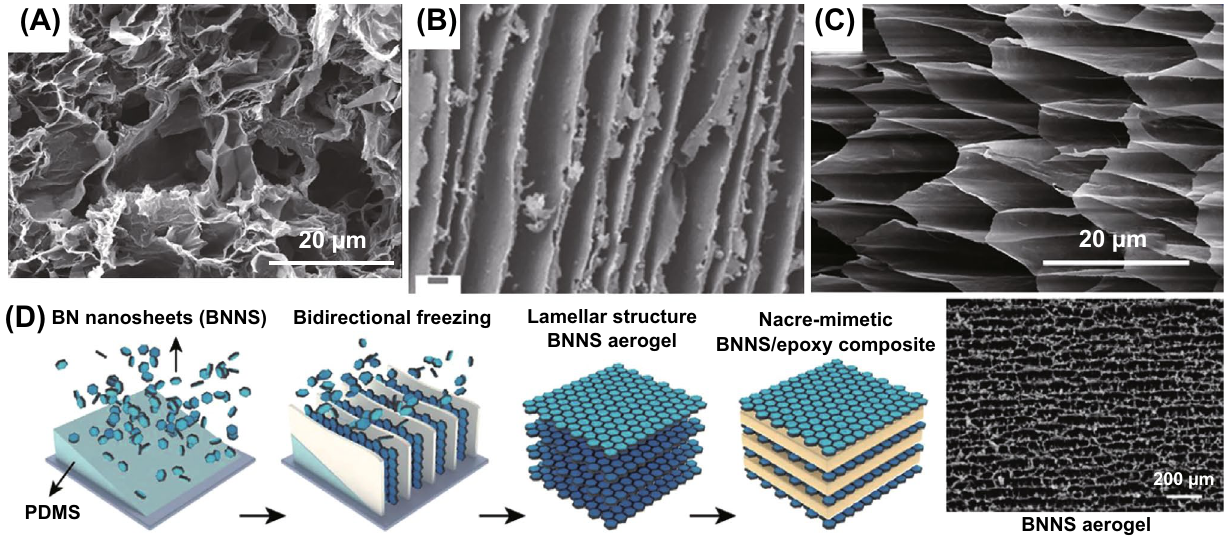
Fig. 7 A SEM of disordered freeze-dried of cellulose/graphene nanoplatelets. Reprinted with permission from Ref. [115]. B SEM of freeze- dried anisotropic porous MWCNT/WPU composites. Reprinted with permission from Ref. [116]. C SEM of unidirectional freeze-drying cel- lulose nanofiber/CNTs/PDMS composites. Reprinted with permission from Ref. [117]. D Schematic of the fabrication route using a bidirectional freezing technique to obtain BN/epoxy composites. Reprinted with permission from Ref.